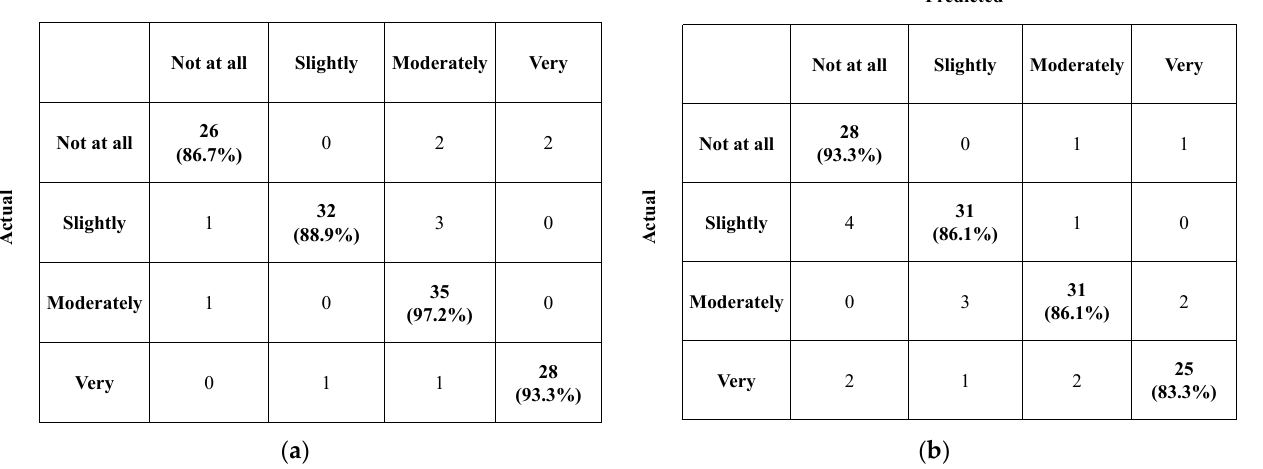
Figure 21. Confusion matrix of ( a ) The monaural MFCC-CNN model; ( b ) The binaural time series CNN model.